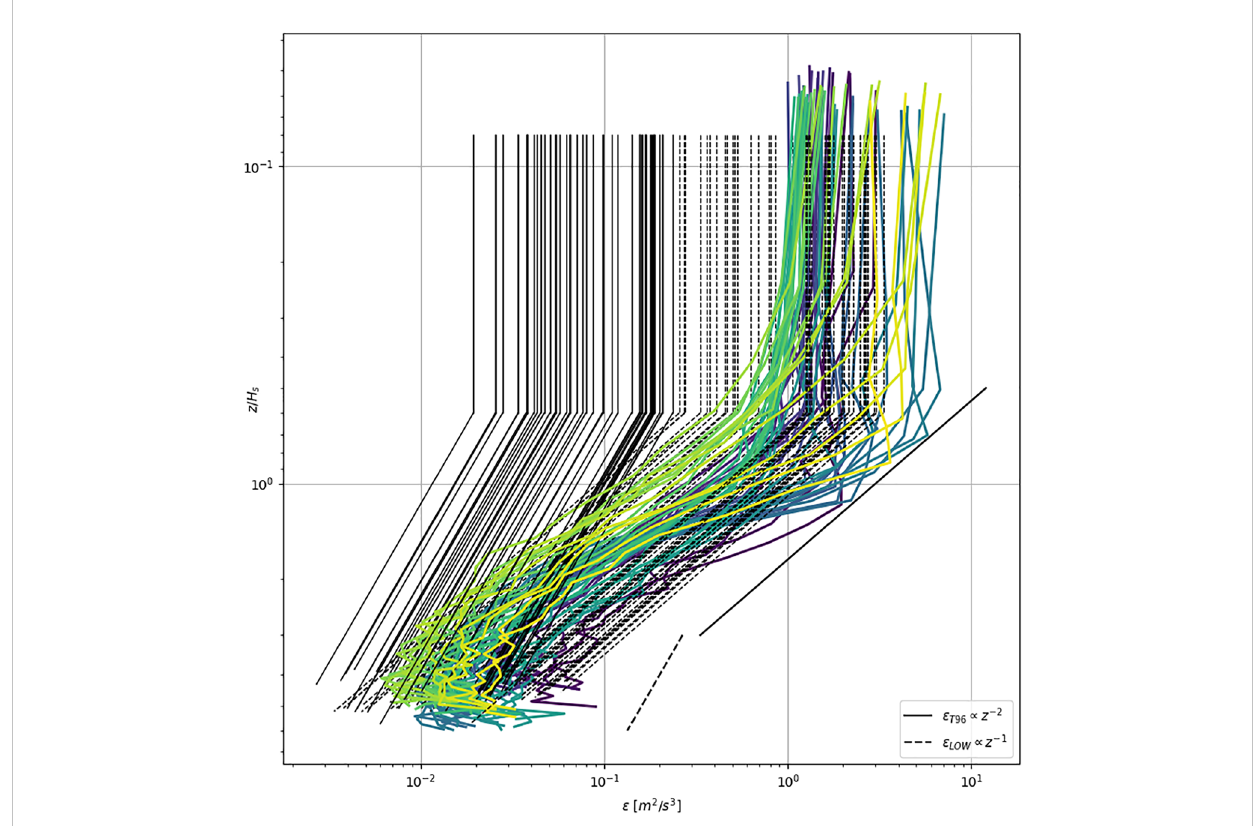
FIGURE 6 Vertical pro fi les of turbulent kinetic energy dissipation as obtained from vertical velocity observations. Dissipation ϵ LOW as derived from wind speed and Eq. 3 is shown in black solid lines, starting at z 0 = 0.6Hs. Dashed lines use wave dissipation measurements F ds (appendix A) and Eq. 10 in Sutherland and Melville (2015) to estimate ϵ as in Terray et al. (1996) for a wave-enhanced turbulence.